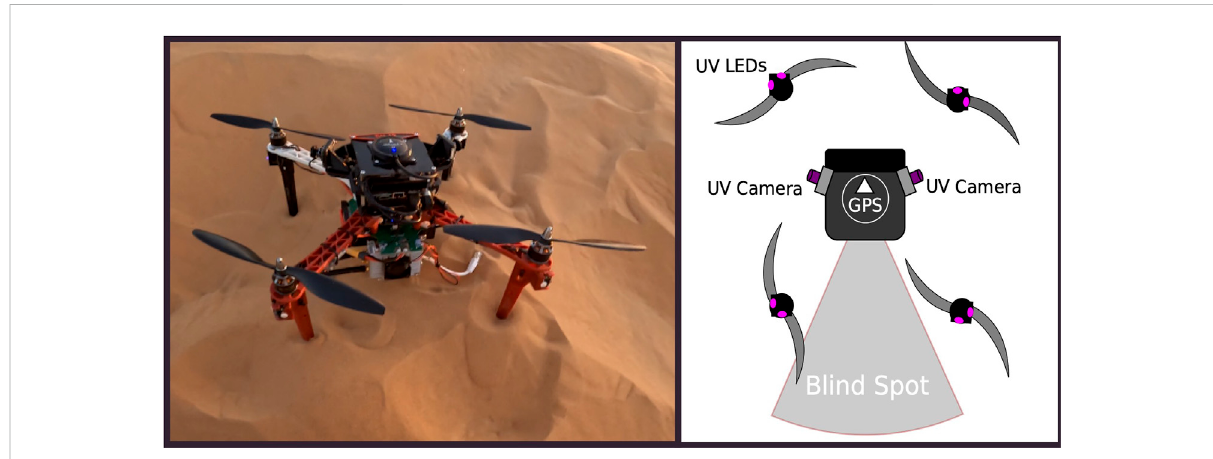
FIGURE 3 (Left): a picture of the real hardware used during the experiments; (right) an abstract representation of the UVDAR setup used during the communication-lessexperiments.Intheleft fi gure,thefollowingelementscanberecognized:MobilicomMCU-30device — grayboxonthebottom of the drone; UV LEDs — small white LEDs located at the edge of each arm; UV-sensitive camera — on the right and the left of the drones peeking out the main